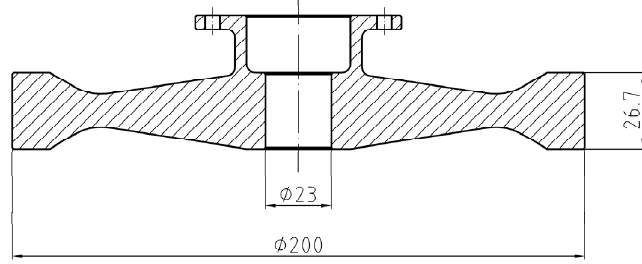
Figure 1. Designed disc geometry and dimensions.